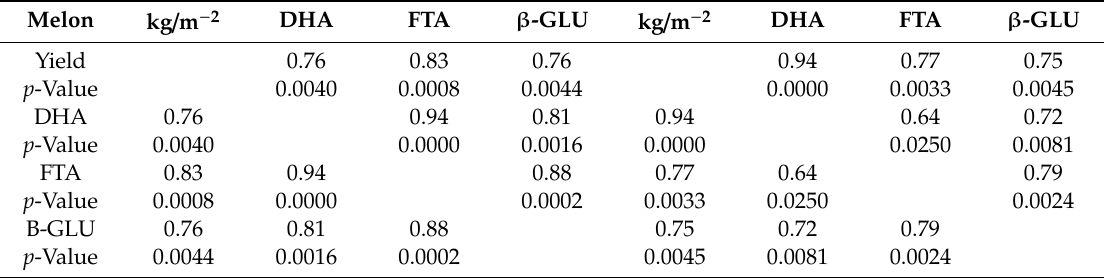
Table 6. Pearson correlation between yield and enzymatic